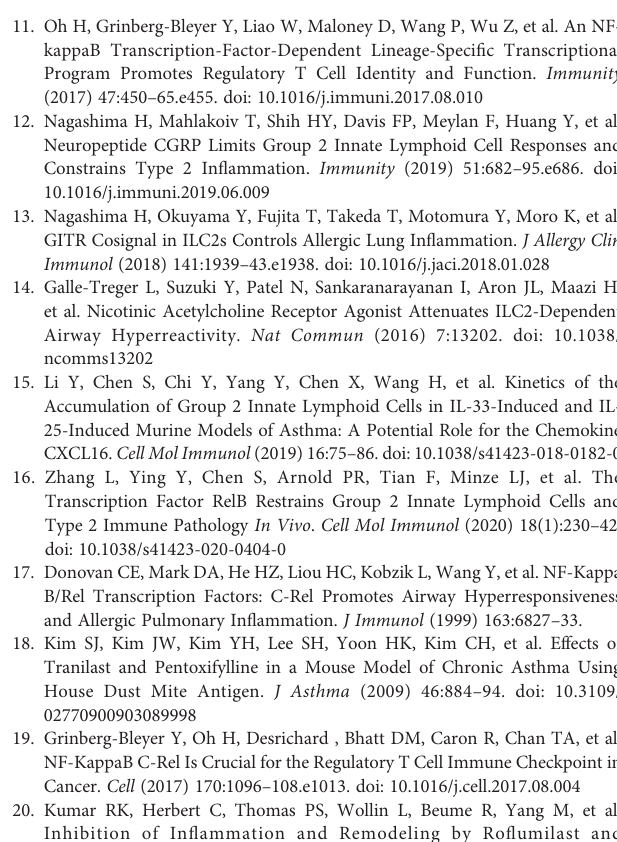
Supplementary Figure 1 | Gating strategies for the identi fi cation of pulmonary type 2 cell populations. (A) Multicolor fl ow cytometry gating strategies to identify murine pulmonary (B) eosinophils (single, live CD45 + SSC hi Siglec-F + CD11c - ), (C) cDC2s (single, live CD45 + CD64 - Lin - MHCII + CD26 + CD11c + XCR1-CD172a + ) as well as (D) ILC2s (single, live CD45 + Lin - Thy-1 + CD127 + KLRG1 + ). cDC2, conventional type 2 dendritic cell. Supplementary Figure 2 | Gating strategies for the identi fi cation of bone marrow ILC2 progenitor populations and isolation of murine lung ILC2s. Flow cytometry gating strategies to (A) identify bone marrow CLP (single live Lin - CD127 + Flt3 + a4b7 - ), CHILP (single live Lin - CD127 + Flt3 + a 4 b 7+ CD25 - ) and ILC2P (single live Lin- CD127 + Flt3 + a 4 b 7+ CD25 + ) populations and (B) isolate murine lung ILC2s (single live Lin-CD45 + Thy-1 + ST2 + CD25 + ). CLP, common lymphoid progenitor; CHILP, common helper ILC2 progenitor; ILC2P, ILC2 progenitor. Supplementary Figure 3 | Gating strategies for the isolation of murine bone marrow-derived ILC2 progenitors and small intestinal ILC2s. Flow cytometry gating strategiestoisolate (A) bone marrow-derivedILC2progenitors(single Lin - Sca-1 + c- Kit - CD25 + ) and (B) murine small intestinal ILC2s (single live CD45 + Lin - KLRG1 + CD127 + ). Supplementary Figure 4 | Absence of c-Rel does not affect GATA3 expression or early ILC2 proliferation upon ex vivo IL-33 challenge. Isolated WT (grey bars) and Rel -/- (redbars) lung ILC2swere leftuntreated (-) orcultured withIL-2, IL-7, IL-33 (all 10 ng/ml) or indicated combinations for 48 hours and analyzed by fl ow cytometry. (A) GATA3 expression, shown as gMFI. (B) Frequencies of Ki-67-expressing lung ILC2s. Data points are representative of two independent experiments with two biological replicates for each stimulation condition. Data are shown as mean ± SD with **p < 0.01 as determined by two-tailed t test (unpaired). gMFI, geometric mean fl uorescence